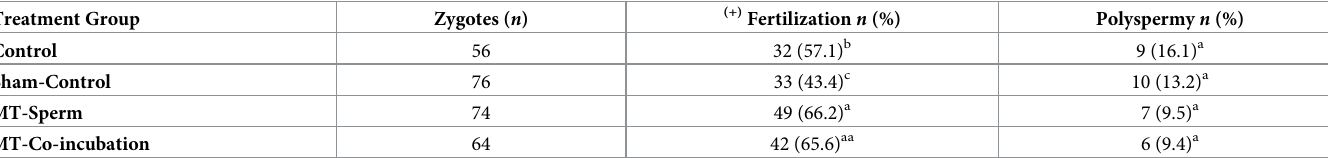
Fig ). Nonetheless, the change between 30 min and 180 min incubation time was characterized